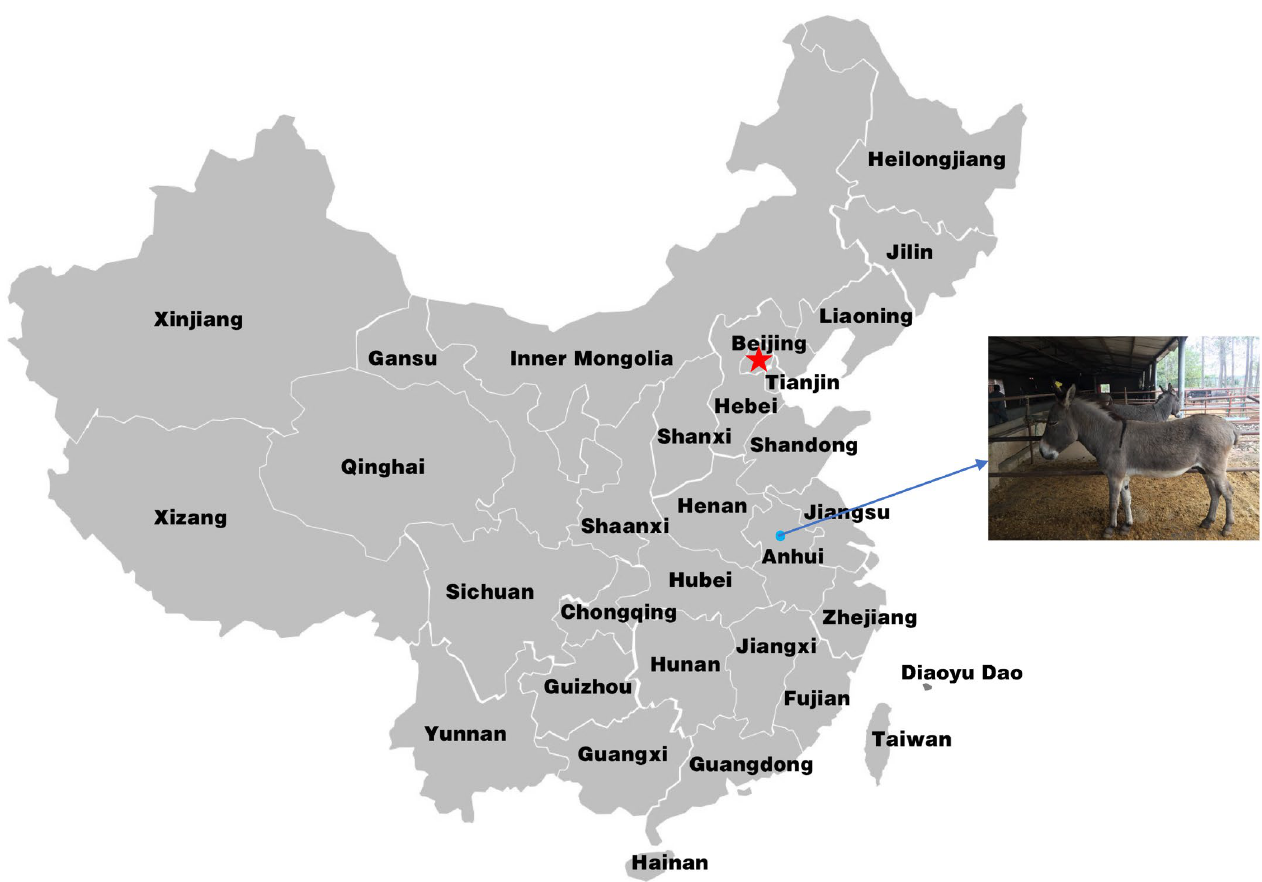
Figure 1. Geographic location of the Huaibei grey donkey.